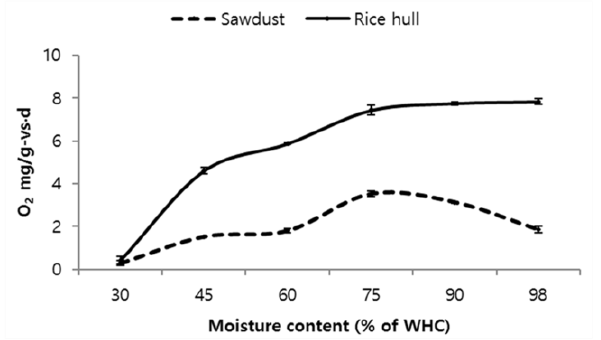
Figure 2. Oxygen uptake rates of sawdust and rice hull as functions of moisture. The error bars give the sample standard deviation between three replicated tests.